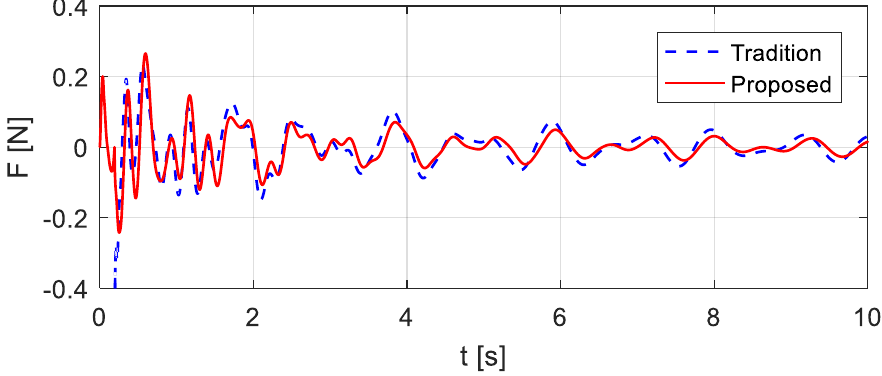
Figure 13. Comparison of the excitations determined by traditional studies and the proposed method.